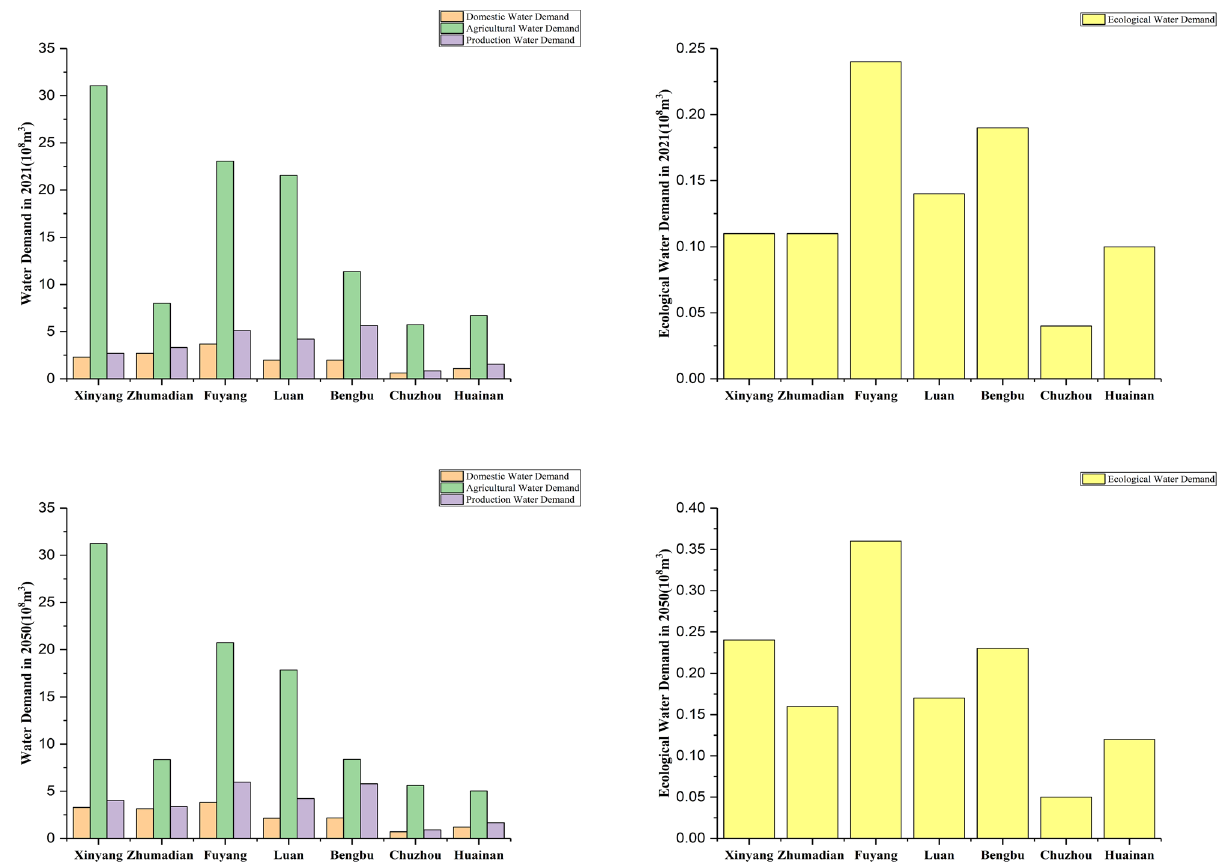
Figure 3. The water demand for each city in 2021 and 2050.